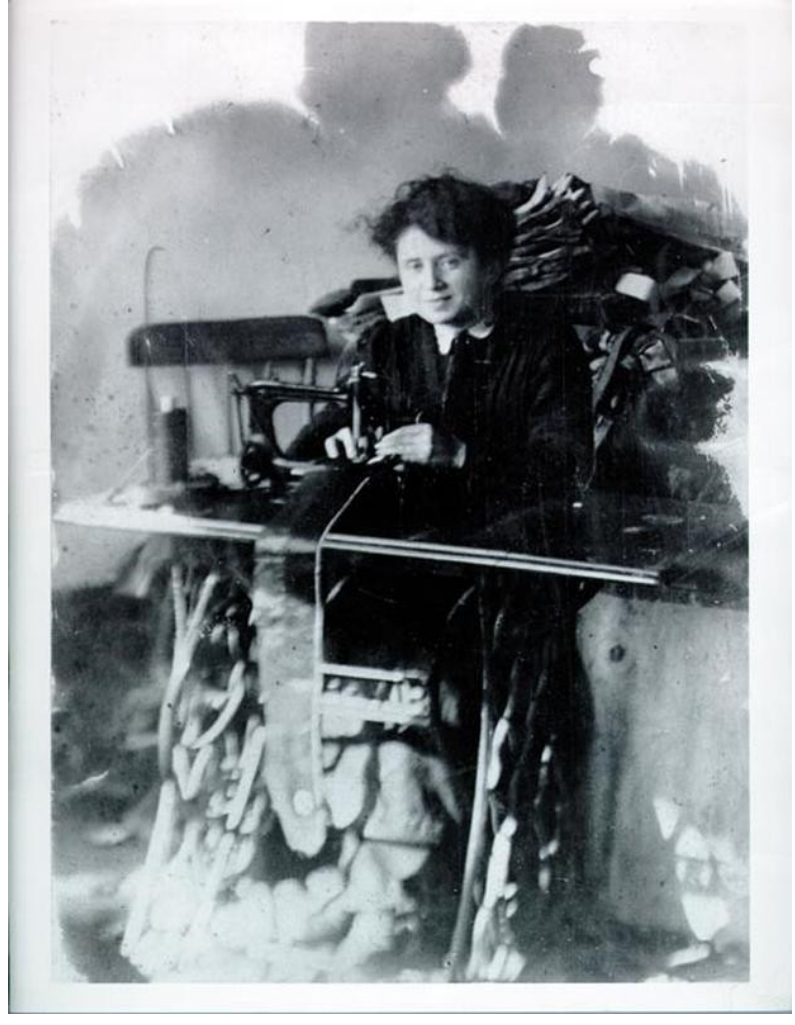
Figure 13. Rose Schneiderman sews a strip of fabric on a machine. Image courtesy of Kheel Center for Labor-Management.